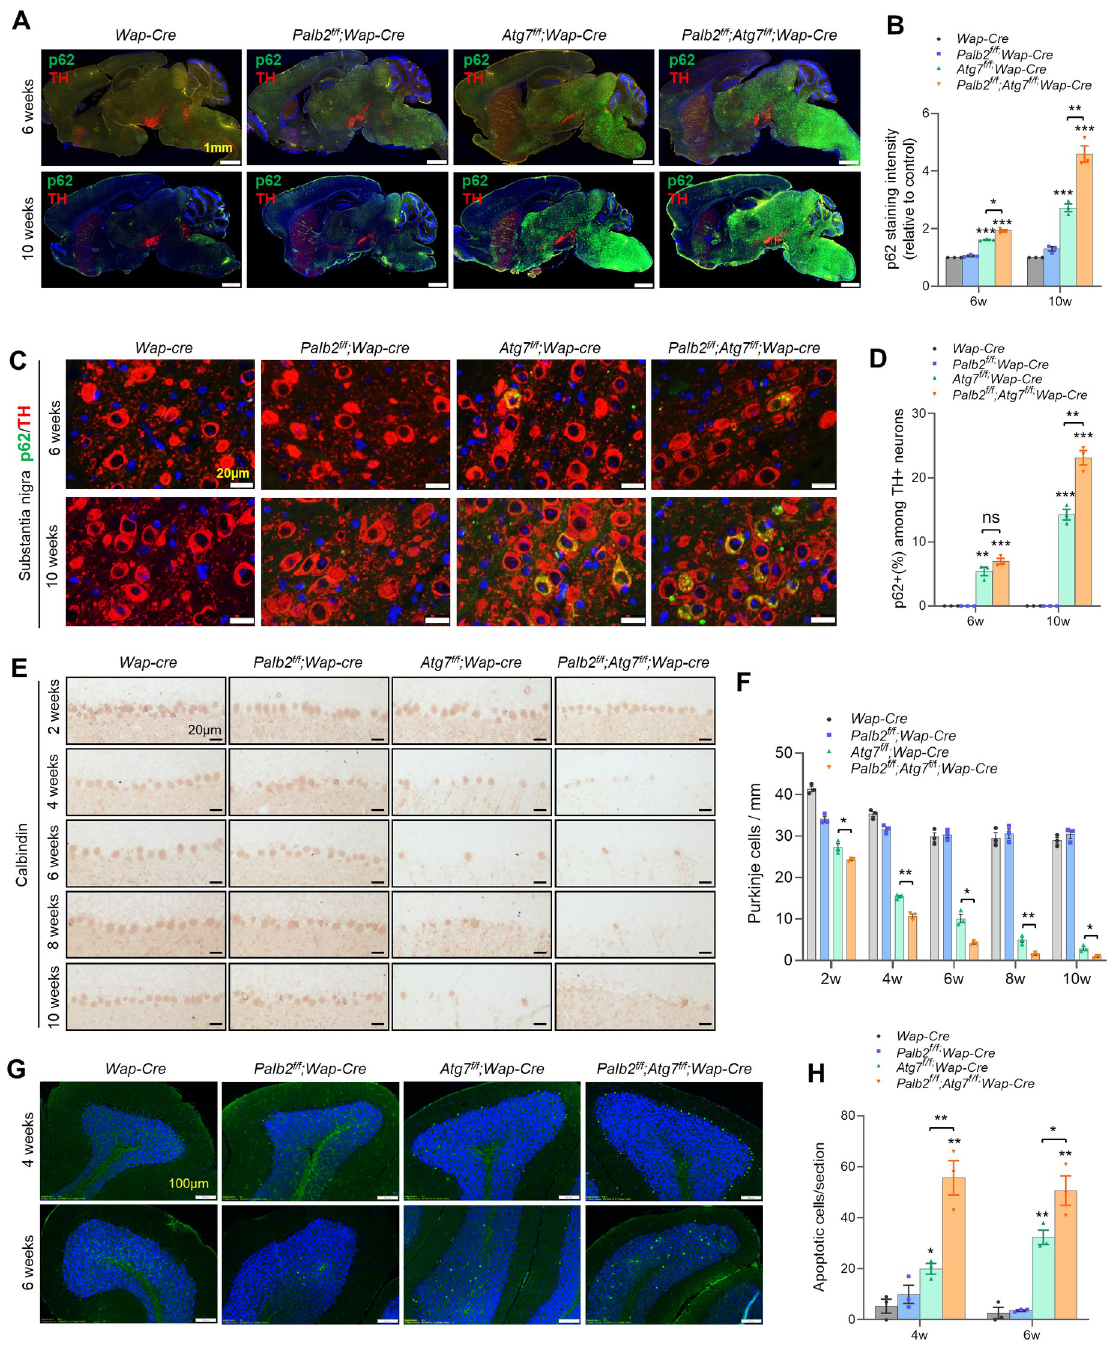
Fig 2. Neuronal degeneration in Palb2 and Atg7 CKO mice. (A-D) Representative immunofluorescence staining of p62/SQSTM1 and TH and quantification of their staining intensity in the whole midsagittal section (A and B) or substantia nigra (C and D) of the brain at 6 and 10 weeks of age. Nuclei were stained with DAPI. Images are representatives of two independent experiments. Scale bar = 1 mm in A and 20 μ m in B as indicated. n = 3 mice per genotype. (E and F) Representative IHC staining of cerebellum with Purkinje cell marker Calbindin (E) and quantification of Purkinje cells (F) at 2, 4, 6, 8 and 10 weeks of age. n = 3 mice per genotype. Scale bar = 20 μ m. (G and H) Representative TUNEL images (G) and quantification of positive cells (H) in the brains of CKO mice at 4 and 6 weeks of age. Scale bar = 100 μ m. n = 3 mice per